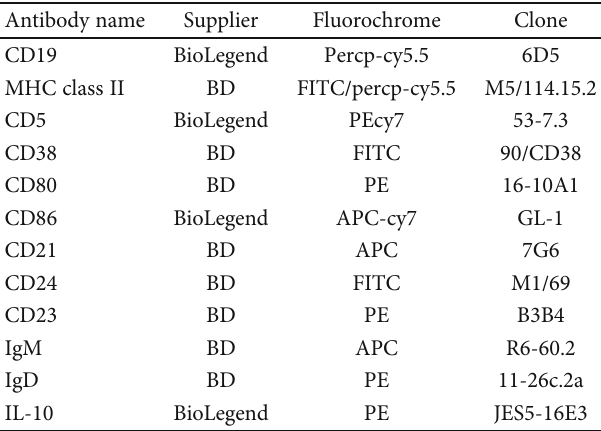
Table 1: The antibodies used in fl ow cytometry.